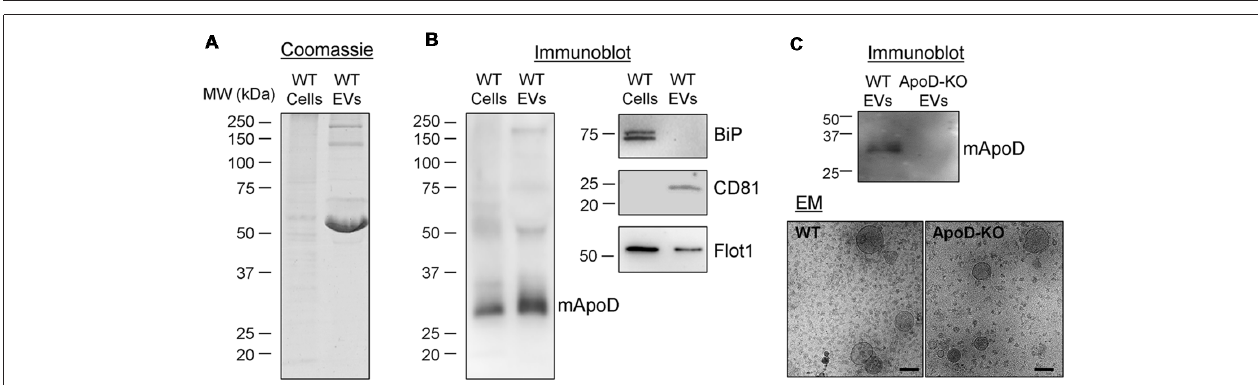
FIGURE 5 | Astroglial EVs promote neuronal survival. (A) SH-SY5Y neurons viability in control and oxidative stress (OS) conditions [2 mM paraquat (PQ) for 2 h], measured by the 3-(4,5-dimethylthiazol-2-yl)-2, 5-diphenyltetrazolium bromide (MTT) assay after culture in SM, astrocyte-CM, purified astrocyte EVs, or EV-depleted astrocyte-derived supernatant, Sup. (B) Cell viability of PQ-challenged SH-SY5Y neurons (2 mM PQ for 2 h) in the absence or presence of purified native ApoD and/or an equimolar amount of anti-ApoD antibody. Error bars represent SEM ( n = 3 independent experiments with three technical replicas each). Asterisks represent significant differences ( p < 0.01) assessed by ANOVA with Holm-Sidak post hoc method. (n.s.: non-significant differences) Only the most relevant comparisons are pointed.